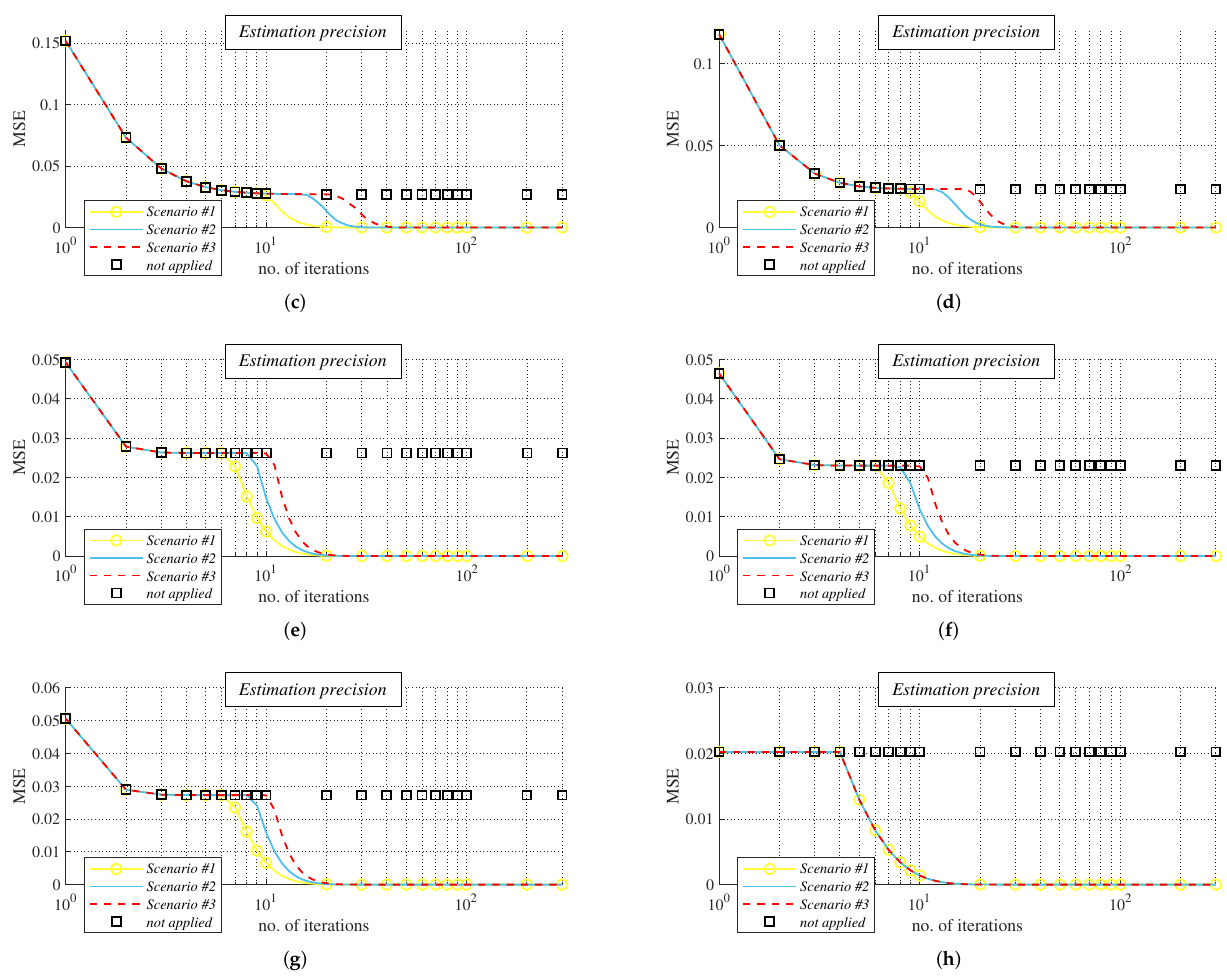
Figure 18. Evolution of mean square error in bipartite regular graphs with various degrees under four various scenarios. ( a ) Bipartite 2-regular graphs. ( b ) Bipartite 3-regular graphs. ( c ) Bipartite 4-regular graphs. ( d ) Bipartite 5-regular graphs. ( e ) Bipartite 6-regular graphs. ( f ) Bipartite 7-regular graphs. ( g ) Bipartite 10-regular graphs. ( h ) Bipartite 15-regular